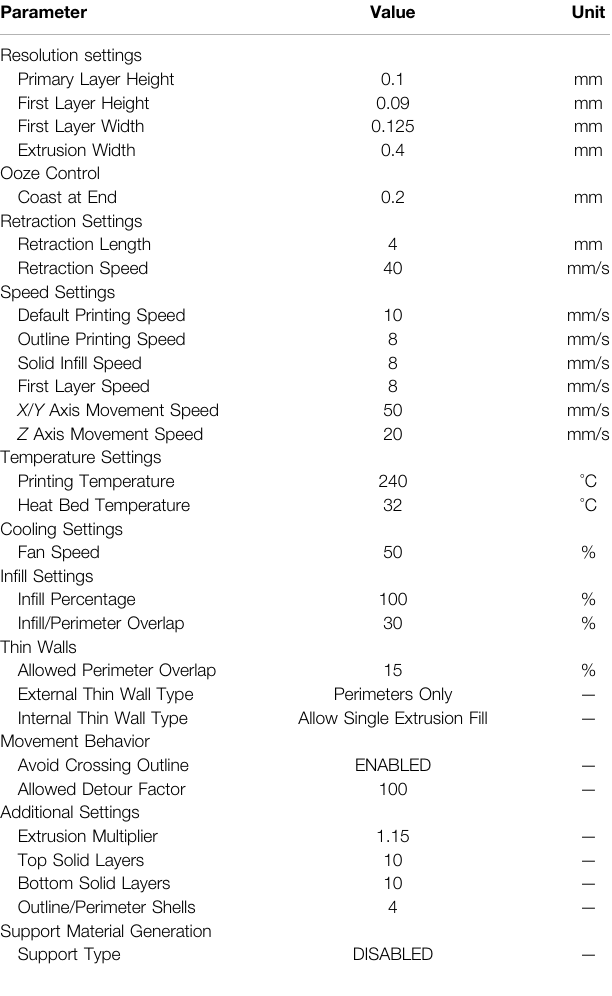
TABLE 1 | Optimized parameters in Simplify3D (Version 4.1.2) for 3D printing airtight soft monolithic pneumatic actuators with integrated metamaterial.